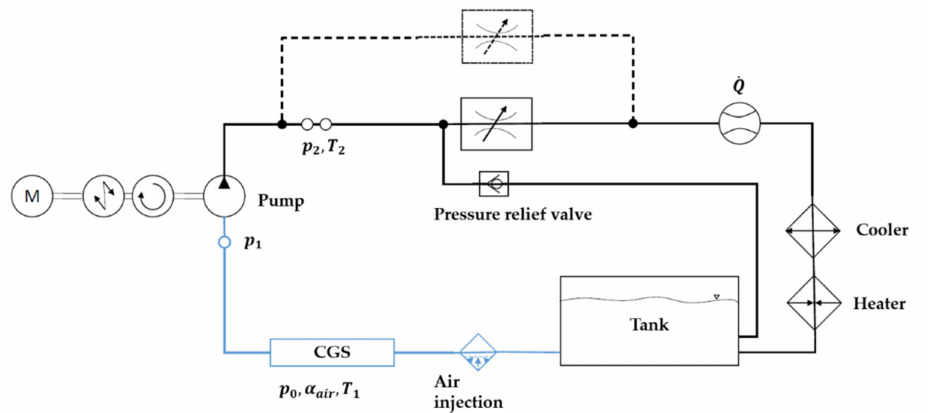
Figure 12. Hydraulic scheme of the test bench.